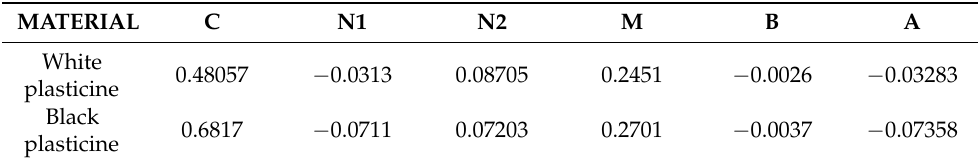
Table 1. Constant of the white and black plasticine material models.